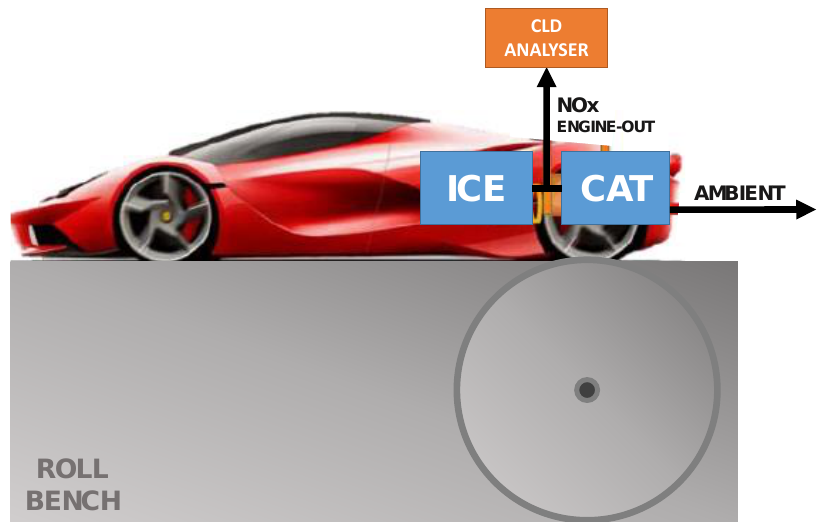
Figure 3. Schematic layout of the roll bench with CLD